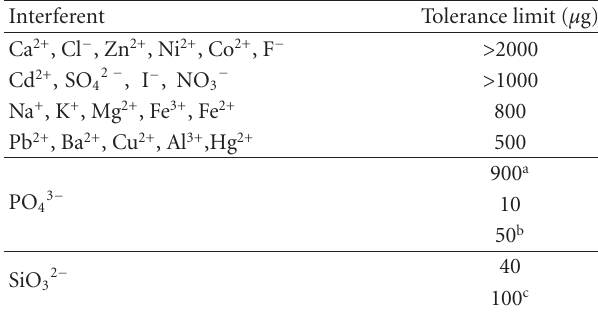
Table 1: E ff ect of foreign ions.